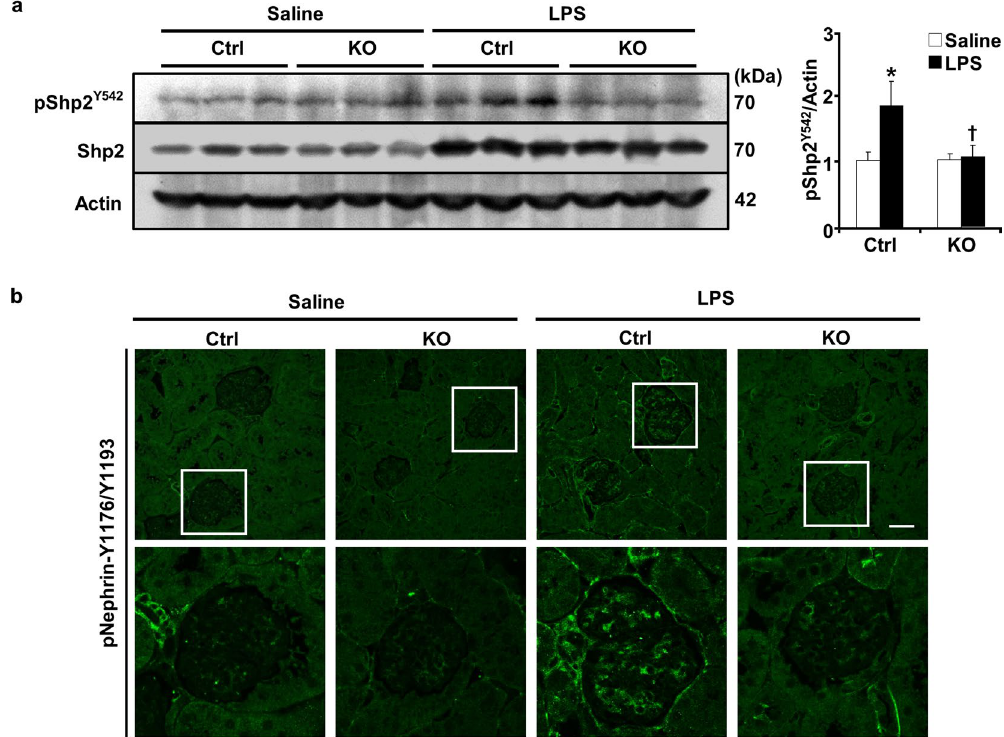
Figure 5. Attenuated LPS-induced Shp2 and nephrin phosphorylation in pod-Shp2 KO mice. ( a ) Kidney lysates from control (Ctrl) and pod-Shp2 knockout (KO) mice without (saline) and with LPS treatment were immunoblotted for pShp2 (Tyr542), Shp2 and actin as a loading control. Representative images are shown and each lane represents an animal. Bar chart represents pShp2 (Tyr542)/actin as means + SEM (n = 6). * p < 0.05 indicates a significant difference between saline and LPS treatments; † p < 0.05 indicates a significant difference between Ctrl and KO mice. A.U., arbitrary units. ( b ) Immunostaining of pNephrin (Y1176/Y1193) in kidney sections from Ctrl and KO mice without (saline) and with LPS treatment. Lower panel includes enlarged images that are highlighted by white boxes in the upper panel. Scale bar: 50 µ